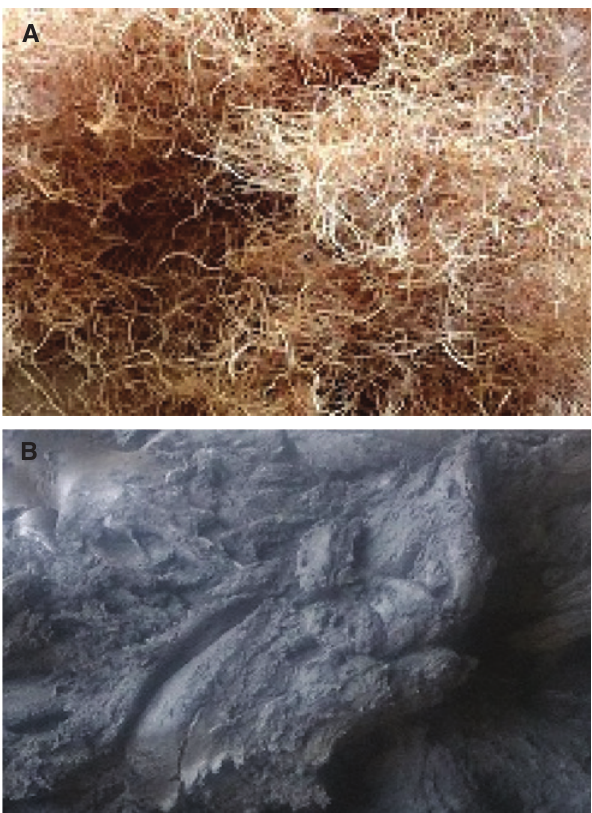
Figure 1: Optical micrograph of: (A) Raw coir fiber. (B) Raw vulcanized